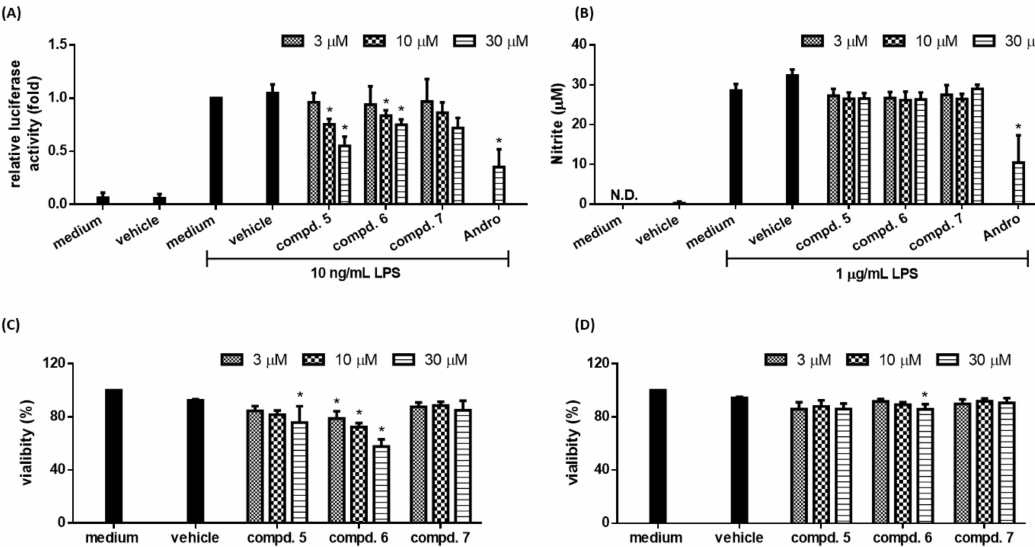
Figure 7. The anti-inflammatory effects of sesquiterpene analogues 5 – 7 on LPS-stimulated macrophages. ( A ) RAW264.7/Luc-P1 macrophages (1.5 × 10 5 cells in 24-well plates) were treated with indicated sesquiterpenes analogs or 0.1% DMSO for 1 h, followed by LPS (1 µ g/mL) treatment for 23 h. The luciferase activity of treated groups was measured; ( B ) RAW 264.7 macrophages (4 × 10 4 cells in 96-well plates) were treated with indicated compounds or 0.1% DMSO for 1 h, followed by LPS (1 µ g/mL) treatment 23 h. Culture supernatants were measured for the production of NO using Griess assays. Andro (andrographolide) is the positive control. Data are expressed as the mean ± SD from three independent experiments. Asterisk (*) indicates significant difference versus LPS-treated vehicle control ( p < 0.05). The cell viability of RAW 264.7/Luc-P1 cells (1 × 10 4 cells in 96-well plates) ( C ) and RAW 264.7 cells (1 × 10 4 cells in 96-well plates) ( D ) incubated with sesquiterpene analogs for 24 h was measured using MTT assay. Data are expressed as the mean ± SD from three independent experiments. Asterisk (*) indicates significant difference versus vehicle control ( p <